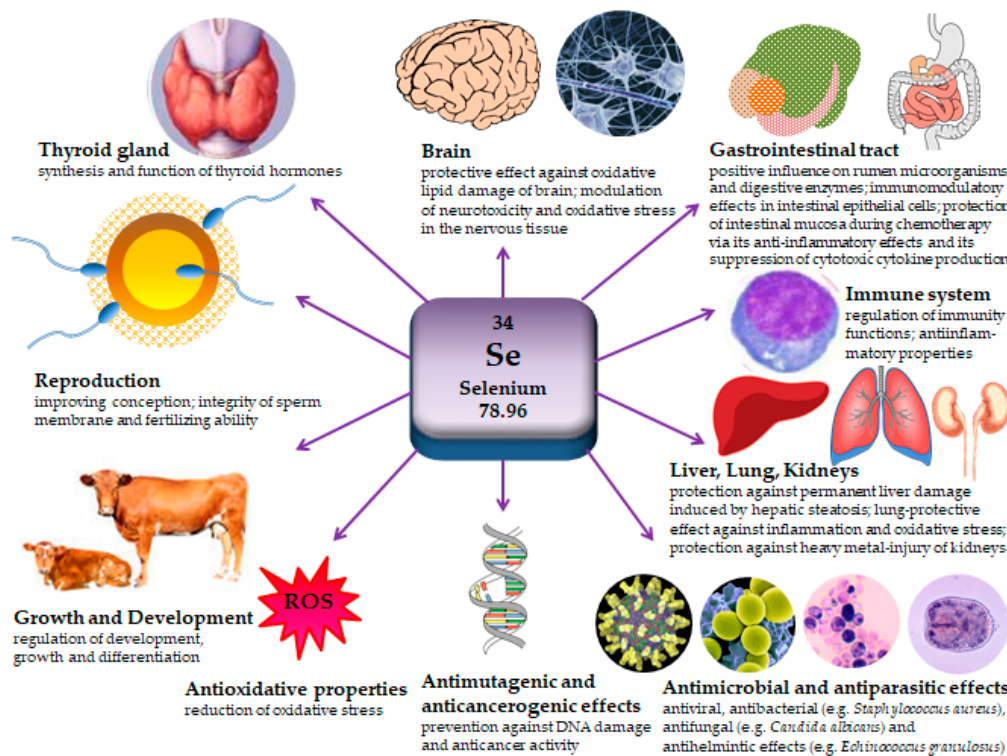
Figure 1. Physiological effects of selenium. Selenium is known for its antioxidant, antimutagenic and anticarcinogenic properties, it also acts against microbes as well as parasites and has